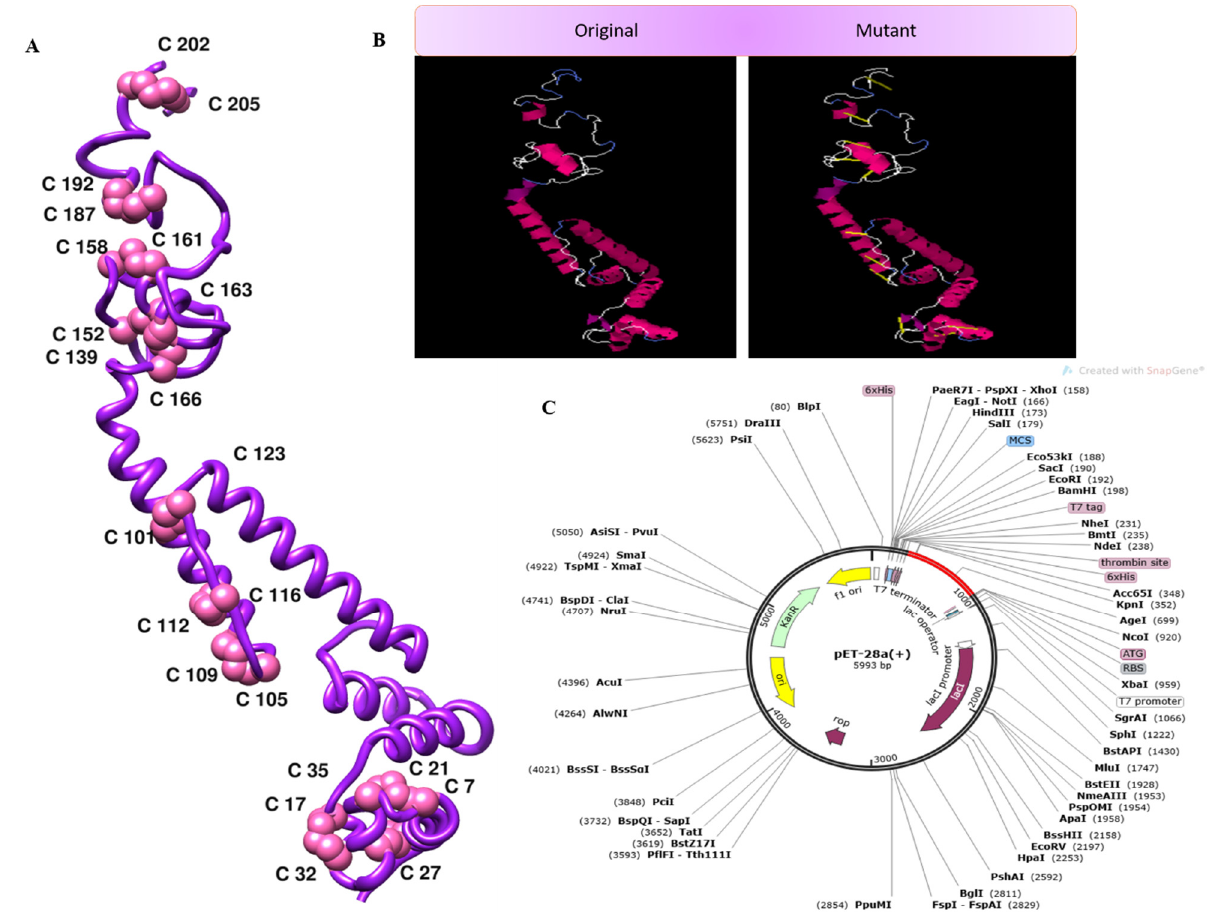
Figure 8. ( A ) 3D structure of the mutant vaccine. ( B ) Mutant and wild vaccine. ( C ) Translated DNA sequences cloned in the pET28a (+) plasmid.